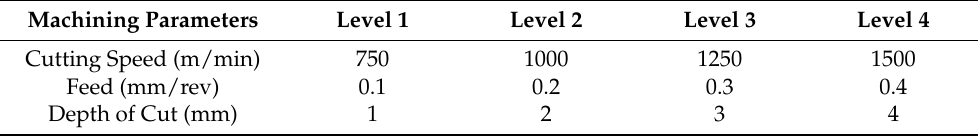
Table 2. L 16 experimental plan for transitional speed machining (TSM).